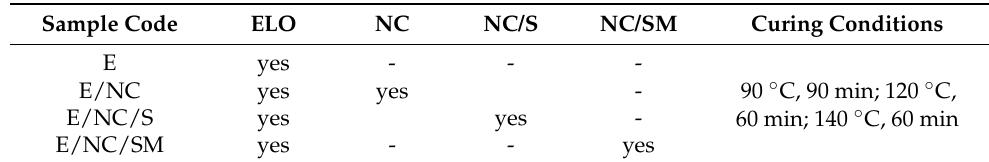
Table 3. ELO-derived nanocomposites formulations and curing conditions employed in their prepa-